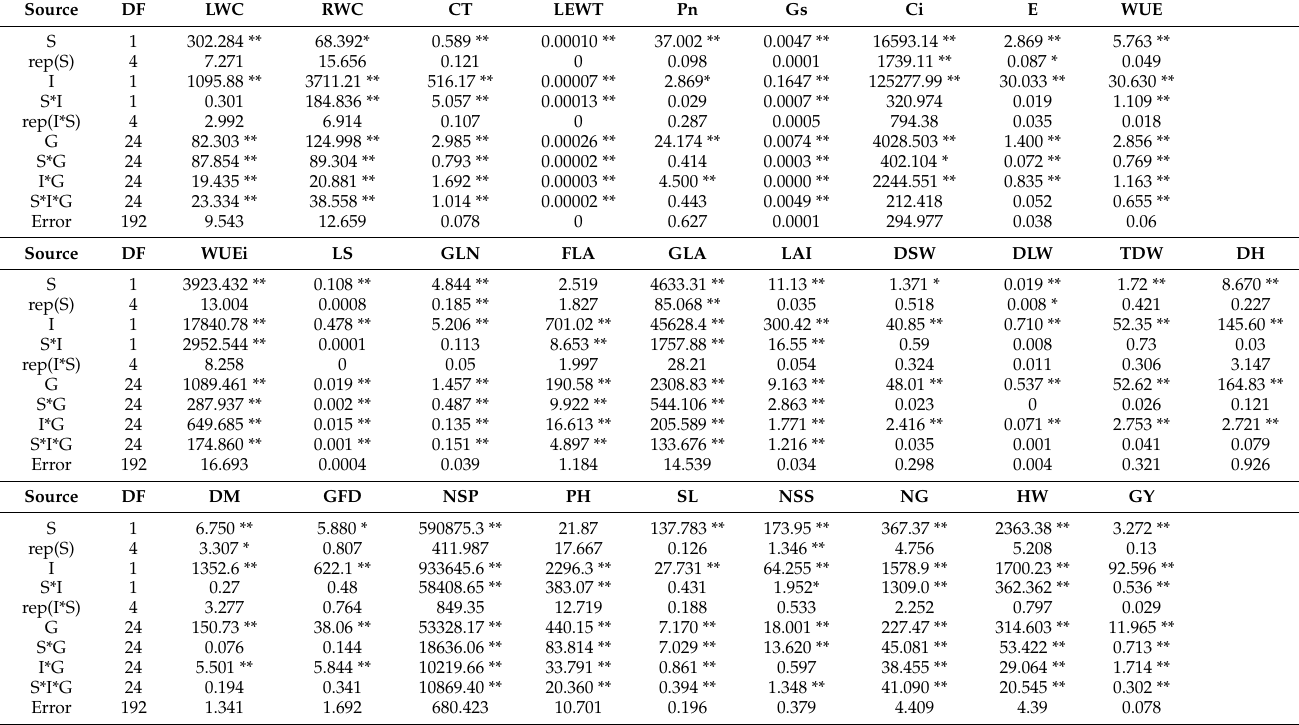
Table 1. Combined analysis of variance for 28 measured traits of 25 wheat genotypes (G) in two seasons (S) under two irrigation regimes